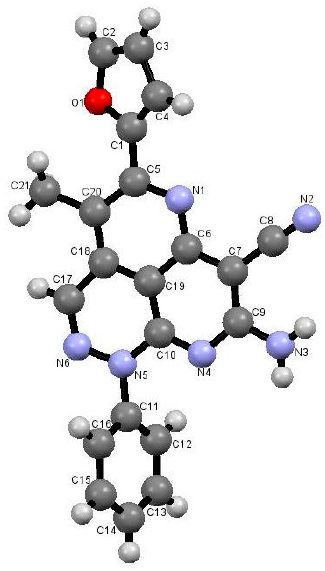
Figure 3. X-ray crystallographic structure of compound 12n [27].